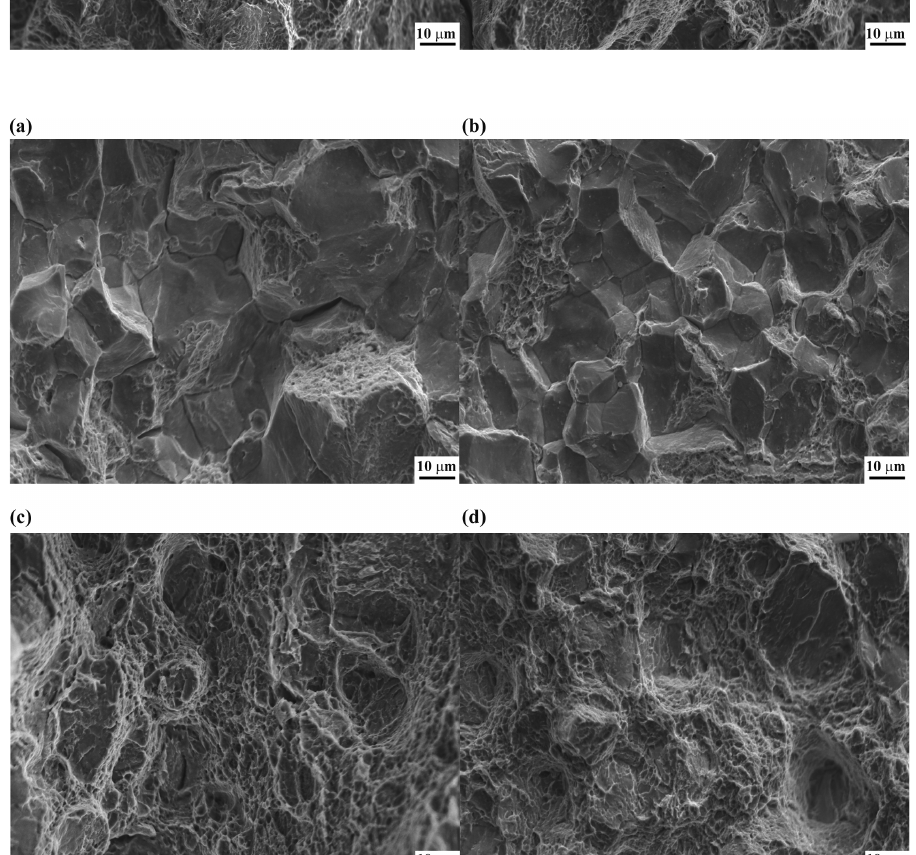
Figure 8: The tensile fractures of the spring steels at different cooling rates: (a) 0.5°C/s, (b) 1°C/s: the reticular proeutec- toid ferrite; (c) 3°C/s, (d) 5°C/s: the blocky proeutectoid